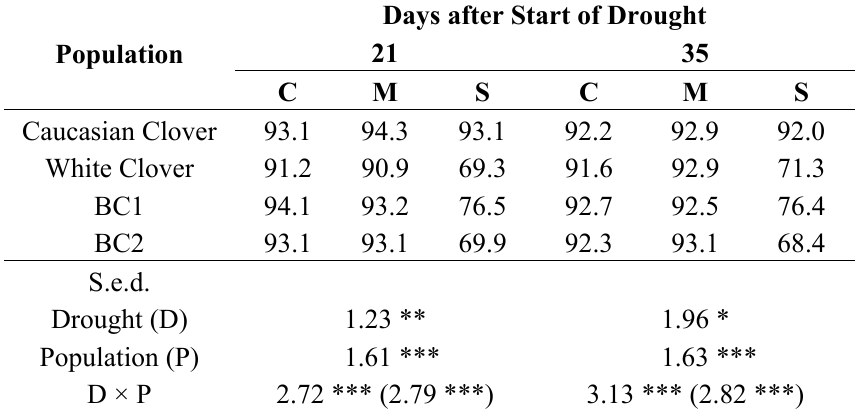
Table 3. Leaf relative water content (%) of Caucasian clover, white clover, BC1 and BC2 hybrids after 21 and 35 days at three levels of drought. C––control treatment, M––moderate moisture stress, S––severe moisture